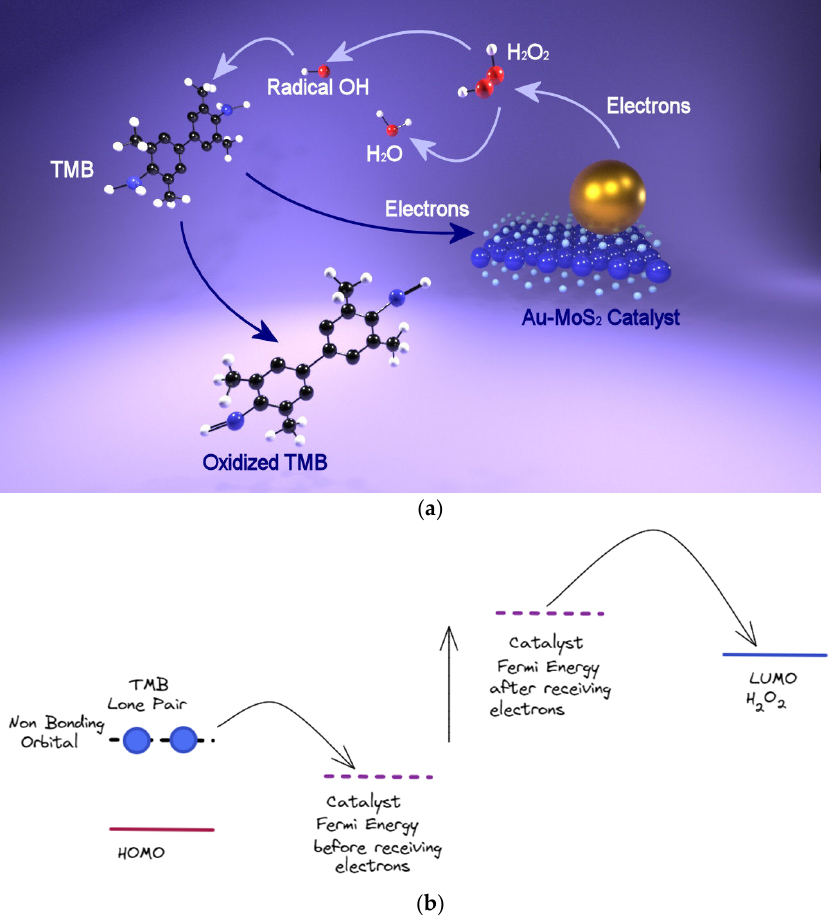
Figure 6. ( a ) Plausible mechanism for the peroxidase-like activity of the hybrid compounds; ( b ) energetics levels for the catalysis.